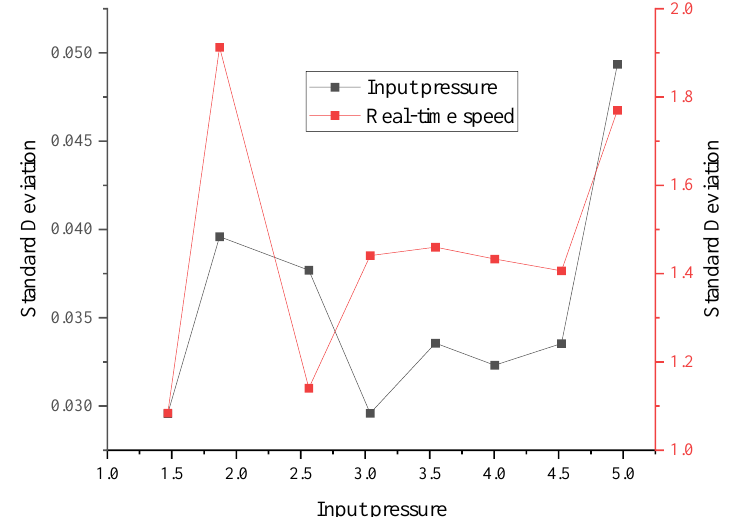
Figure 11. Standard deviation variation.